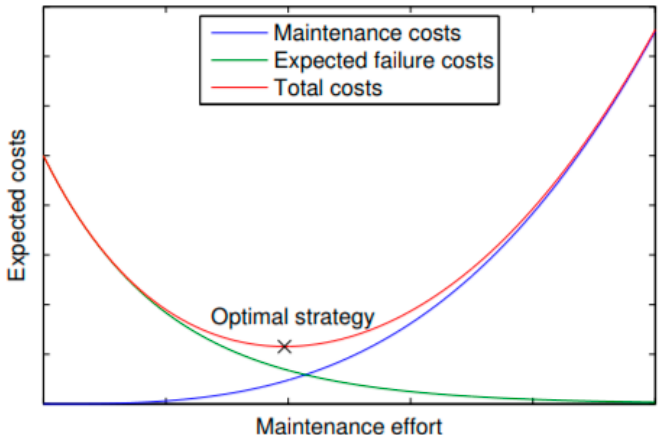
Figure 1. Relationship between expected O&M costs and Maintenance Effort. Green line show that expected failure costs reduce with the Maintenance Effort, whereas the blue line shows that the maintenance costs increase with the rise of Maintenance Effort. The sign (x) shows the optimal strategy point when the total costs are minimum [11].